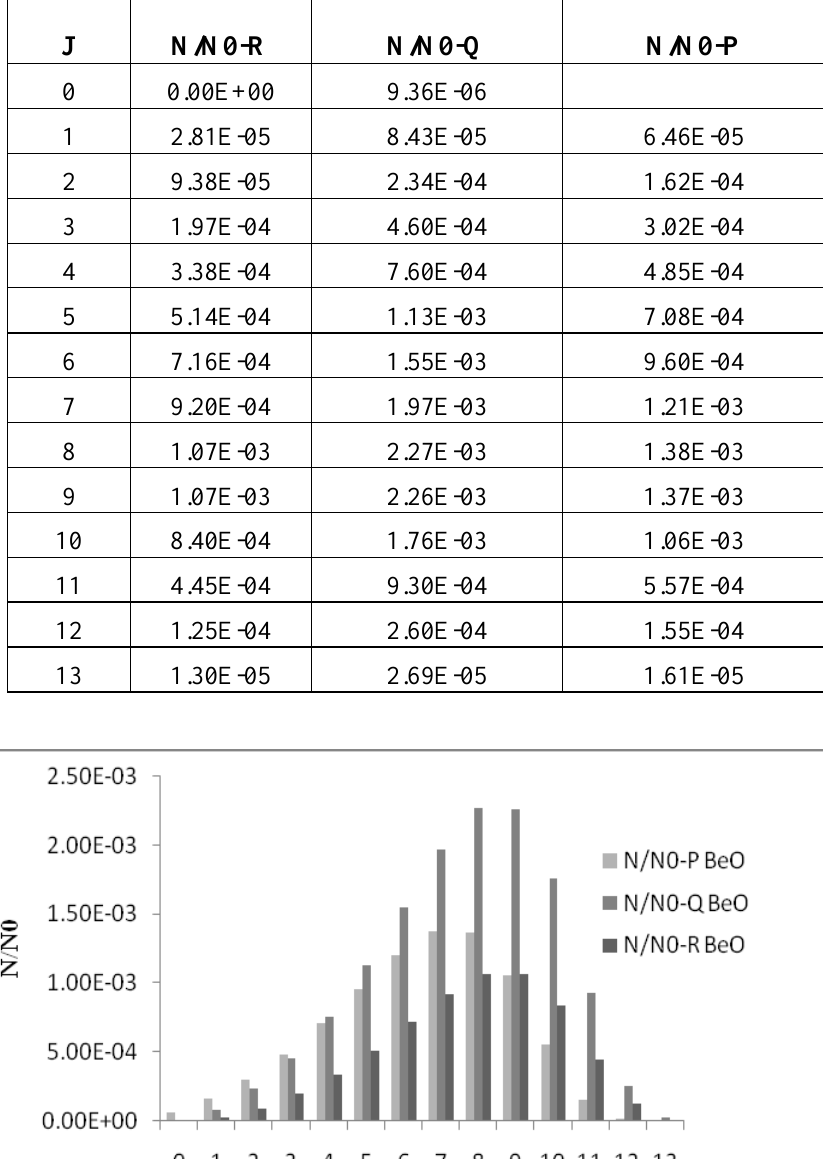
Table 4: The values of relative intensity for Q, P and R branches for B 1 Σ + - A 1 Π transition.